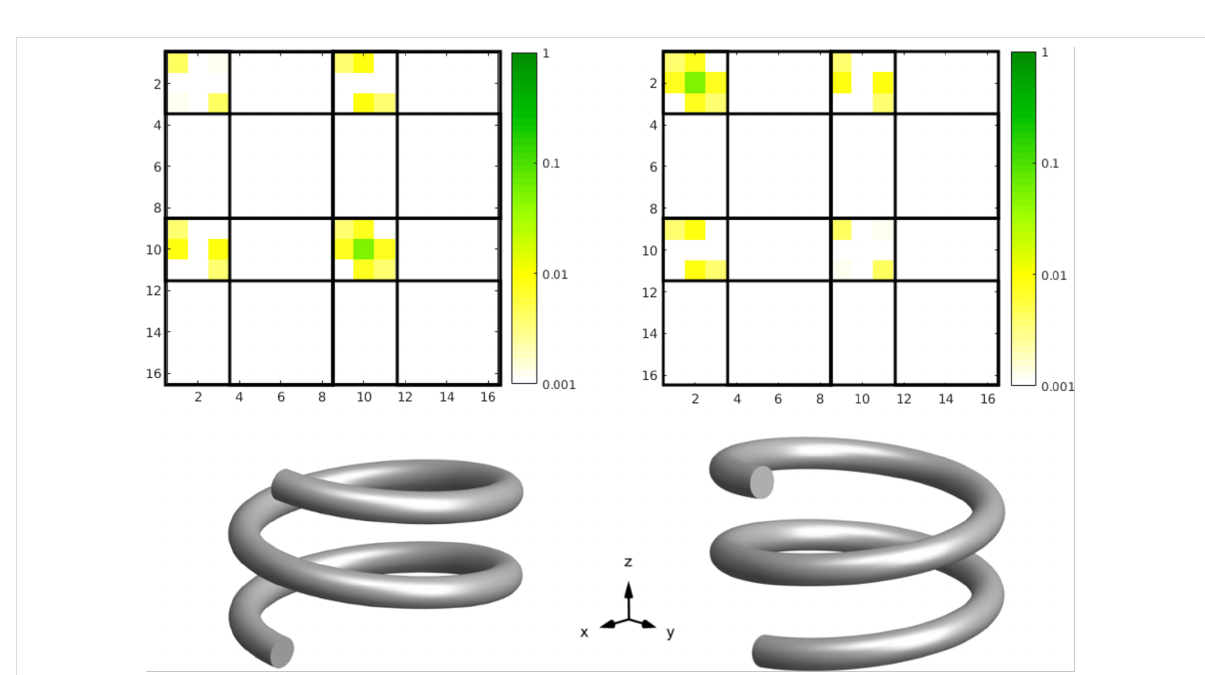
Figure 11: T-matrix entries in the helicity basis (obtained by Equation 22) of a left-handed and a right-handed helix. We clearly observe that each helix interacts primarily only with one helicity and that the mixing of different helicities is very low ( and ). The T-matrices are ordered, in prin- ciple, in the same way as shown in Figure 4, but with helicity + and − states instead of e and